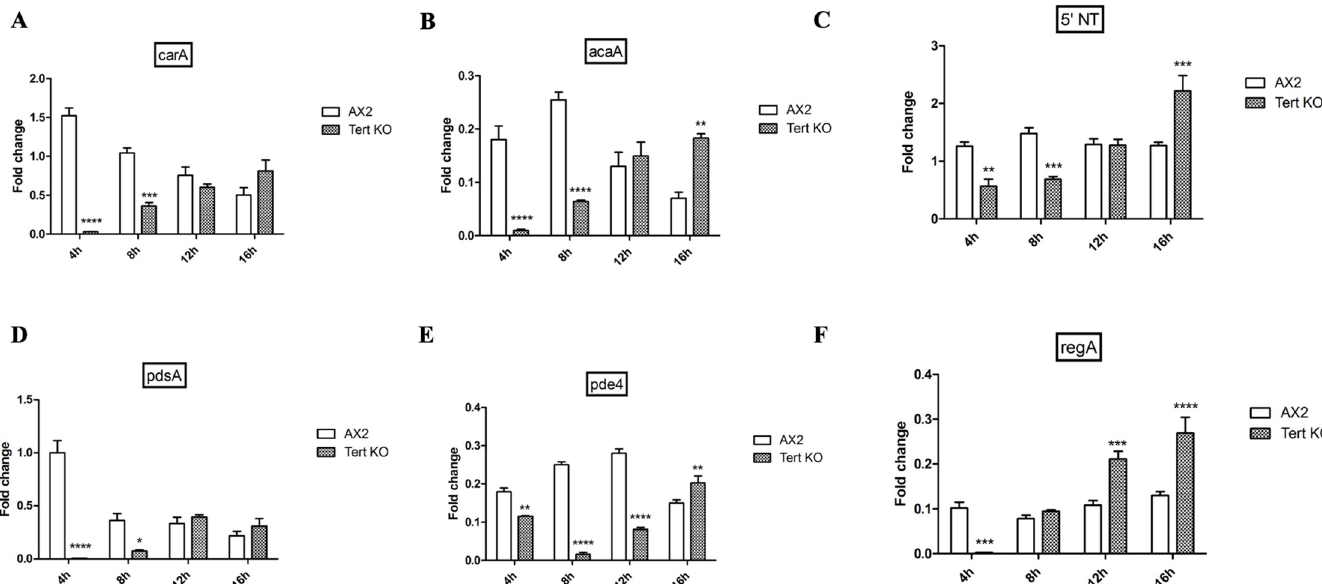
Fig 9. Delayed development in tert KO. (A-F) qRT-PCR of genes involved in the cAMP relay. Down-regulation of genes involved in the cAMP relay in tert KO. Fold change in mRNA expression at the indicated time points. rnlA is used as an mRNA amplification control; (n = 3). Level of significance is indicated as � p < 0.05, �� p < 0.01, ��� p < 0.001, and ���� p < 0.0001; (n = 3).